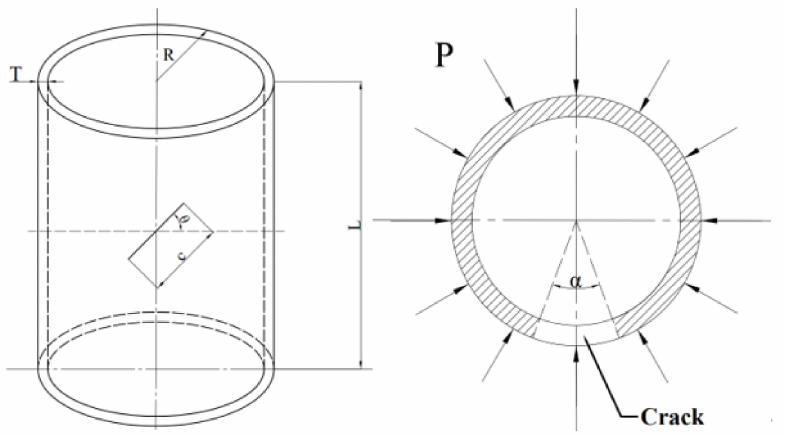
Figure 1. Diagram of a cracked cylindrical